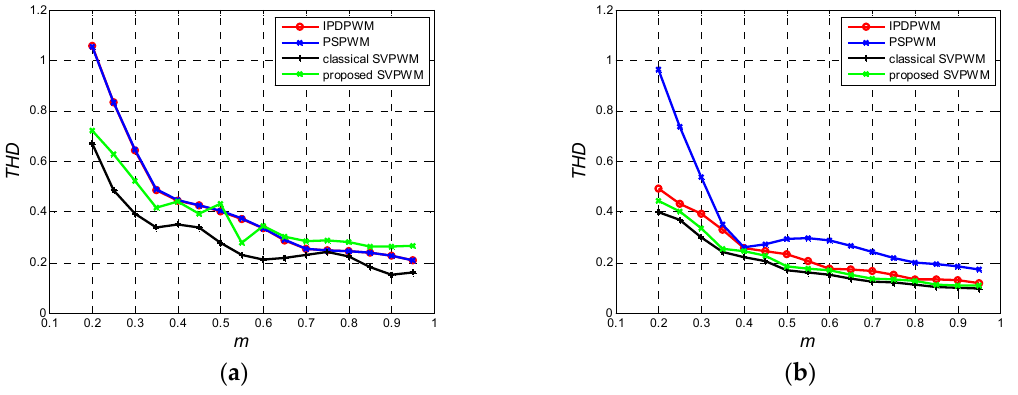
Figure 25. THDs of phase voltage and line-to- line voltage of 5-level inverter with different PWM schemes, ( a ) phase voltage; ( b ) line-to-line voltage